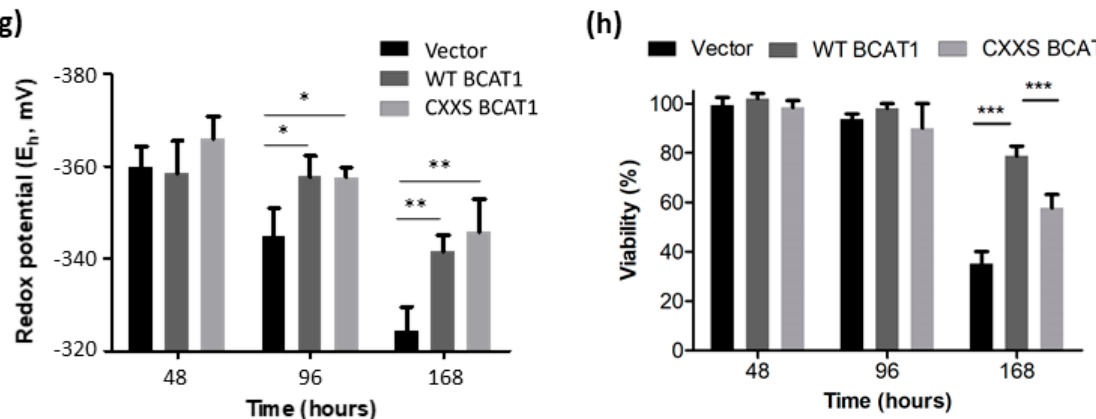
Figure 4. BCAT1 increases growth survival and is associated with altered cellular redox homeostasis in U937 cells. ( a ) Cell density and ( b ) cell viability profile of U937 cells overexpressing WT BCAT1, CXXS BCAT1, and Vector control U937 cells, monitored growth over 0–192 h ( n = 4). Cells were seeded at 2 × 10 5 cells/mL at day 0. ( c ) Bar chart displaying cell viability after 192 h. ( d ) Gating strategy DCFDA analysis for intracellular ROS by flow cytometry. ( e ) Intracellular ROS measured by DCFDA for WT BCAT1, CXXS BCAT1 and Vector control U937 cells at exponential (48 h), stationary (96 h), and death phase (168 h). ( f ) Total glutathione (GSH) content for WT BCAT1, CXXS BCAT1 and Vector control U937 cells at exponential (48 h), stationary (96 h), and death phase (168 h). ( g ) Cellular redox potential at exponential (48 h), stationary (96 h), and death phase (168 h). ( h ) cell viability at exponential (48 h), stationary (96 h), and death phase (168 h). Data presented are mean ± SD. Significant differences were calculated using 2-way ANOVA with Bonferroni post-test where, * p < 0.05, ** p < 0.01 and *** p < 0.001 ( n = 3).